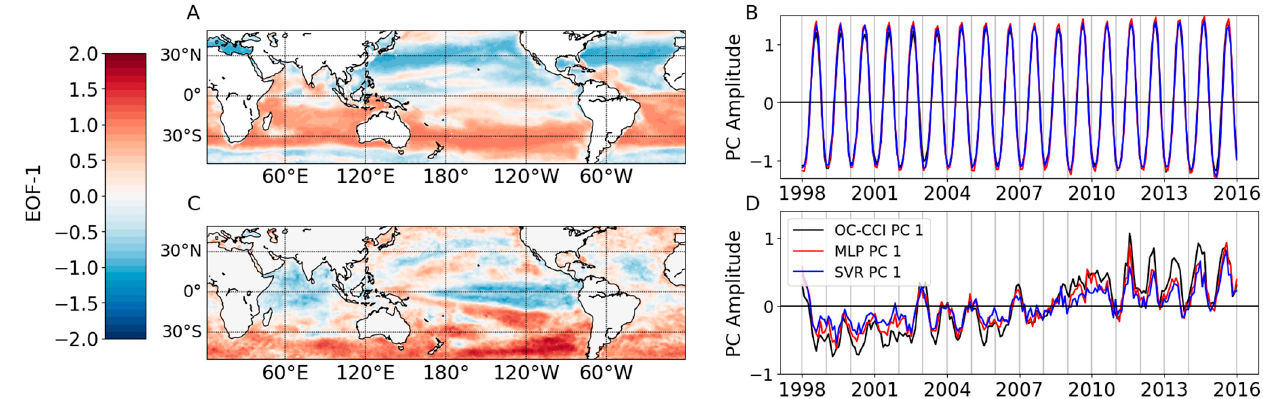
Figure 3. ( A , C ) Correlation and ( B , D ) NRMSE of Chl OC-CCI vs. (up) Chl SVR and (bottom) Chl MLP over 1998–2015.